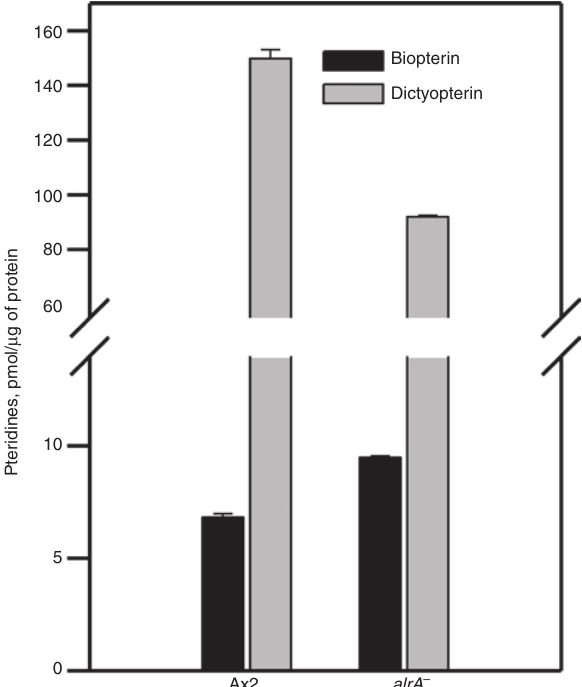
Figure 5: Comparative analysis of pteridine levels in wild type and alrA − cells. The cells grown in the HL5 medium were harvested and determined for total cellular pteridines as fully oxidized forms after acidic iodine oxidation. The two-tailed p values were <